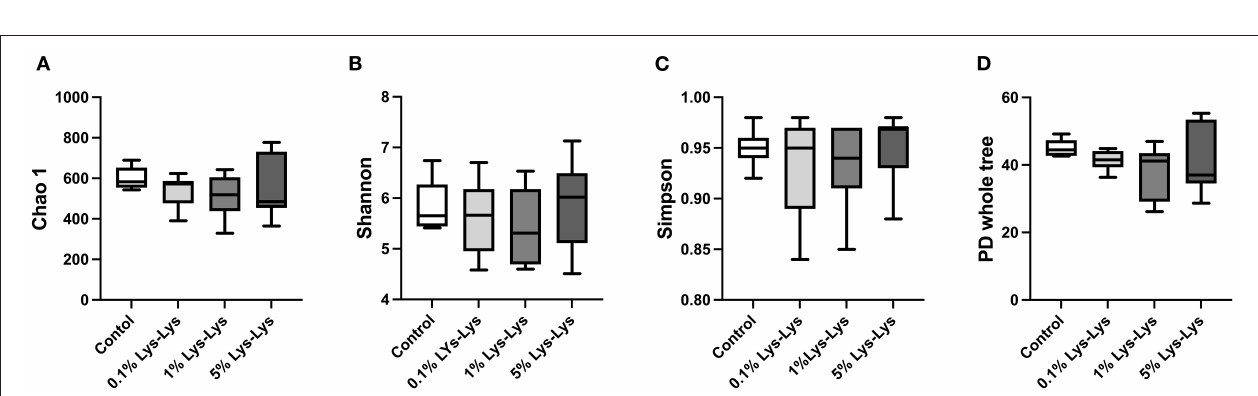
FIGURE 3 | Effect of the Lys-Lys dipeptide on intestinal lysine and dipeptide transporters in piglets. (A) Jejunal Slc7a1 . (B) Jejunal Slc7a2 . (C) Jejunal Slc15a1 . (D) Ileal Slc7a1 . (E) Ileal Slc7a2 . (F) Ileal Slc15a1 . Data were expressed as the mean ± SEM ( n = 7). *Different from control, P < 0.05; **different from control, P < 0.01.